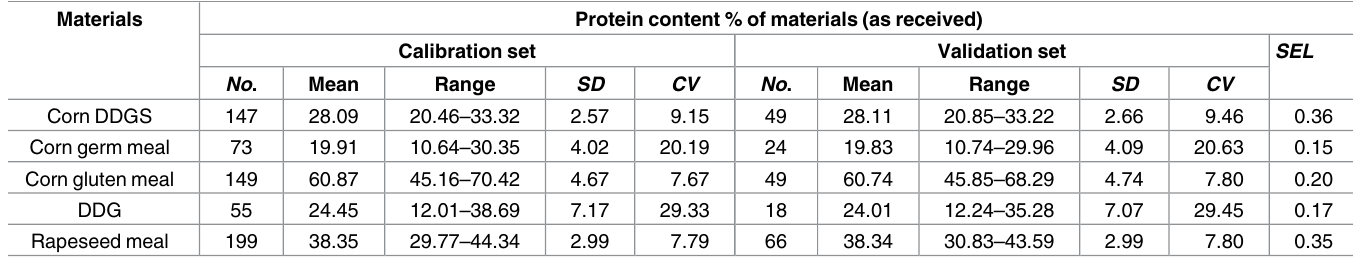
Table 1. Summary of protein content in calibration set and validation set of different plant feed materials.